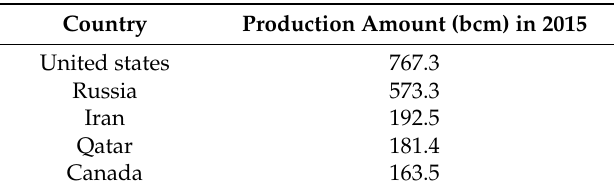
Table 3. Top five natural-gas-producing countries in 2015